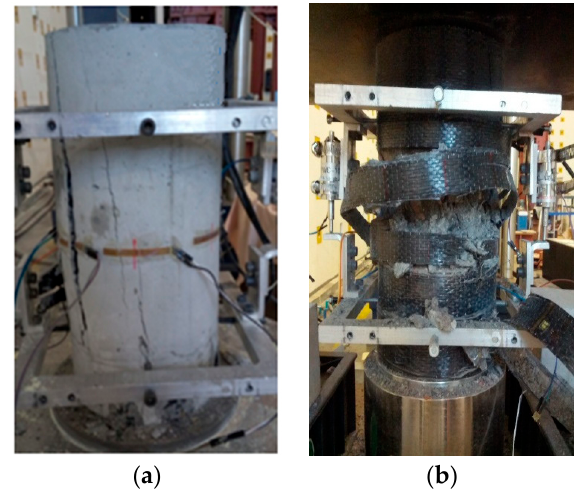
Figure 3. Failure modes. ( a ) Unconfined test specimen; ( b ) Confined test specimen.